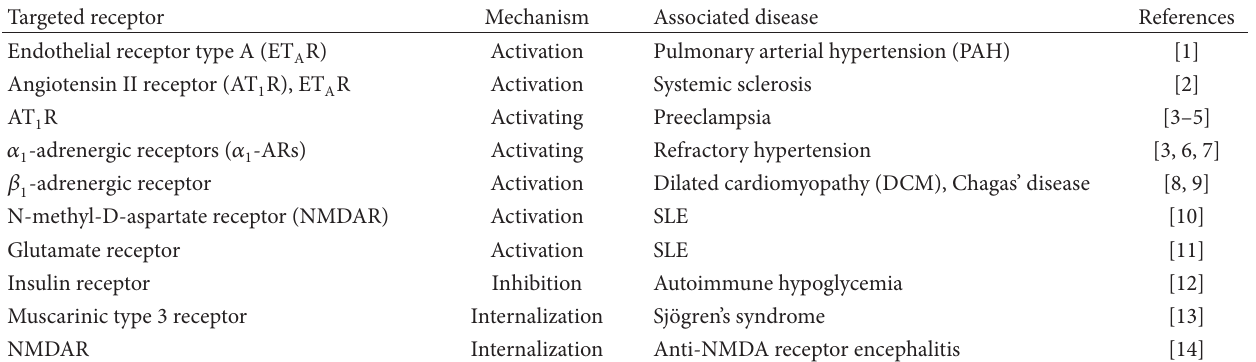
T 1: Examples for receptor